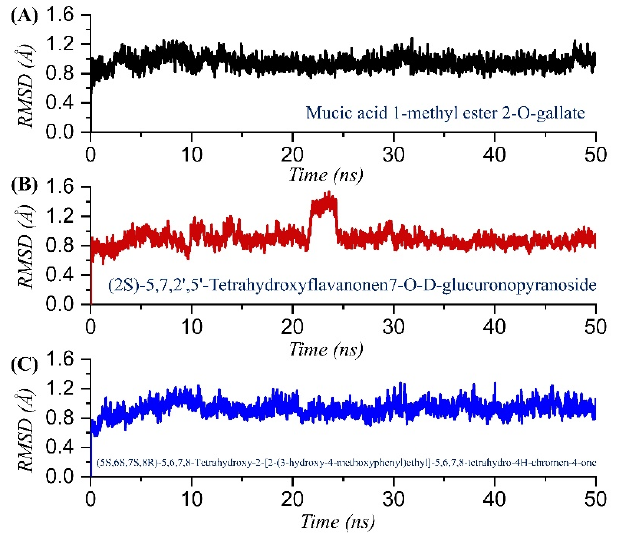
Figure 5. Dynamic stability analysis of the TCM42798, TCM47007, and TCM30675 complexes. ( A ) The RMSD graph for mucic acid 1-methyl ester 2-O-gallate. ( B ) The RMSD graph for TCM47007 or (2S)-5,7,2’,5’-Tetrahydroxyflavanone 7-O--D-glucuronopyranoside. ( C ) The RMSD graph for TCM30675 or (5S,6S,7S,8R)-5,6,7,8-Tetrahydroxy-2-[2-(3-hydroxy-4-methoxyphenyl)ethyl]-5,6,7,8- tetrahydro-4H-chromen-4-1